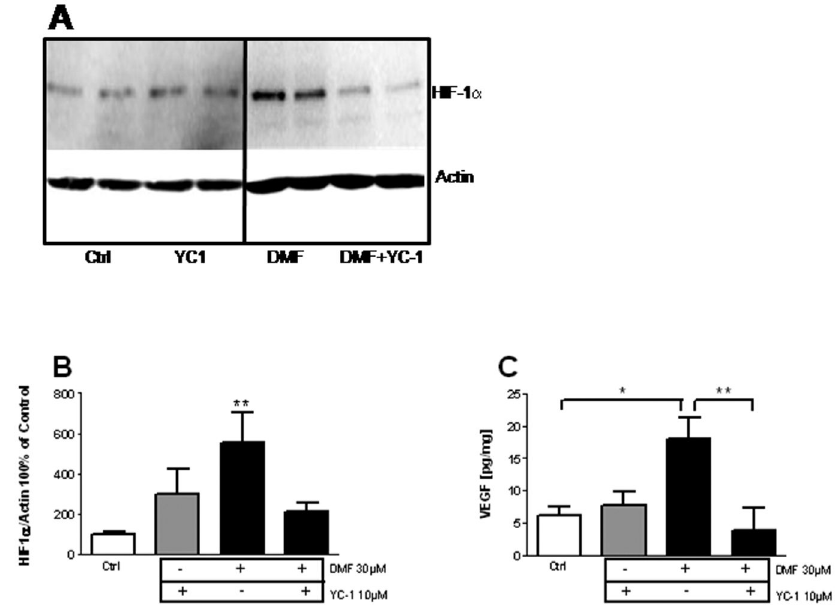
Figure 3. Pharmacological evidence of HIF-1α involvement in VEGF release. Wild type astrocytes were treated with 30µM DMF for indicated times. HIF1-α level was measured by Western-Blot (A) 6h after DMF treatment (B) or 16h after DMF treatment (C). The HIF1-α inhibitor YC-1 was incubated 30min before treatment with DMF. VEGF in the supernatant was quantified by ELISA (C) *p<0,05; ***p<0,001; significantly different from corresponding control. Values are mean+/-SEM of n=3 independent